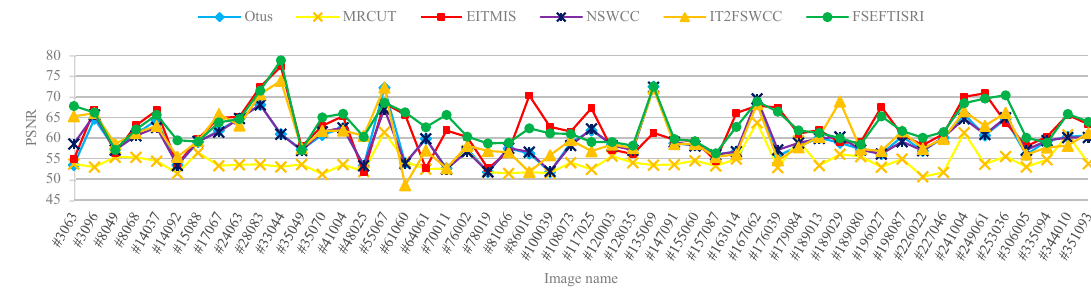
Figure 19. Comparison of PSNR of several algorithms.